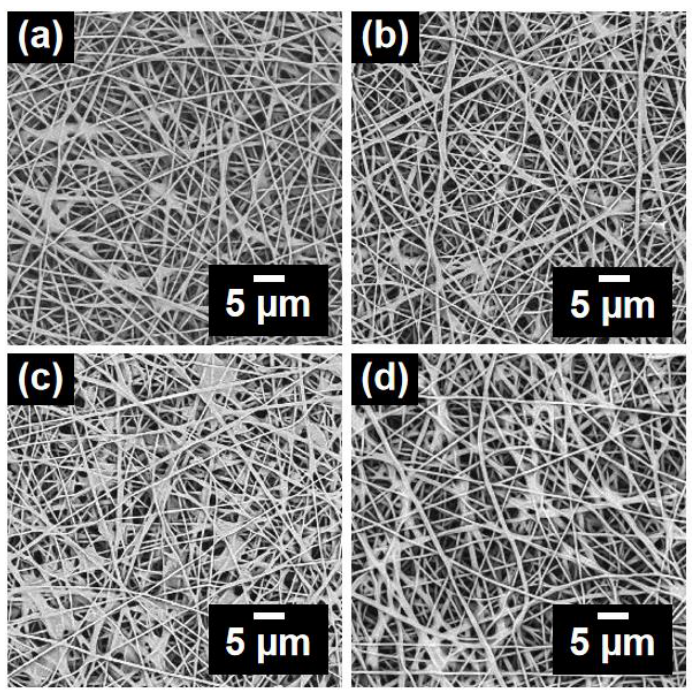
Figure 5. SEM images of PAN@AMP-1/MDI nanofibrous membranes modified by in situ cross-linking of MDI with different concentrations: ( a ) 0.5, ( b ) 1, ( c ) 2 and ( d ) 4 wt%.